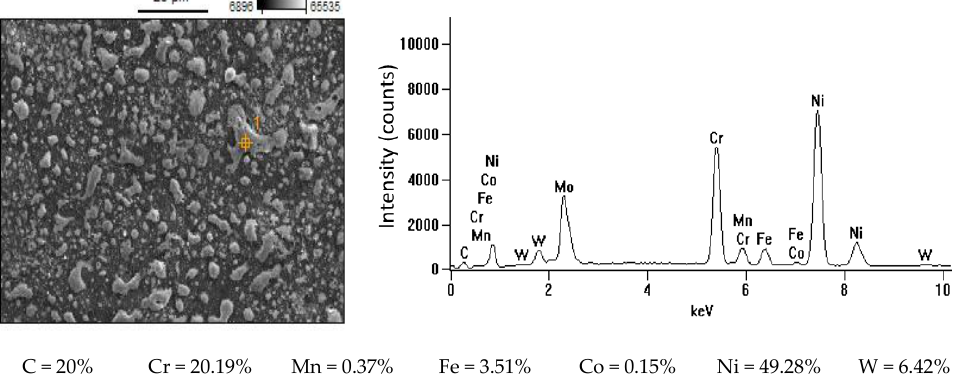
Figure 11. EDS spectrum of surface of AF-5 graphite electrode: I = 3.8 A, t on = 55 µs, t off = 37 µs.